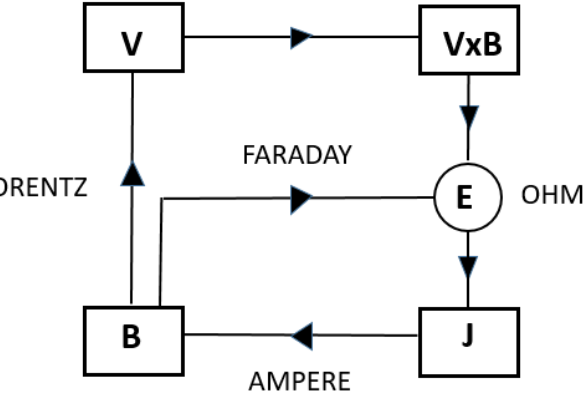
Figure 1. Schematic representation between the plasma motion and magnetic field [2].